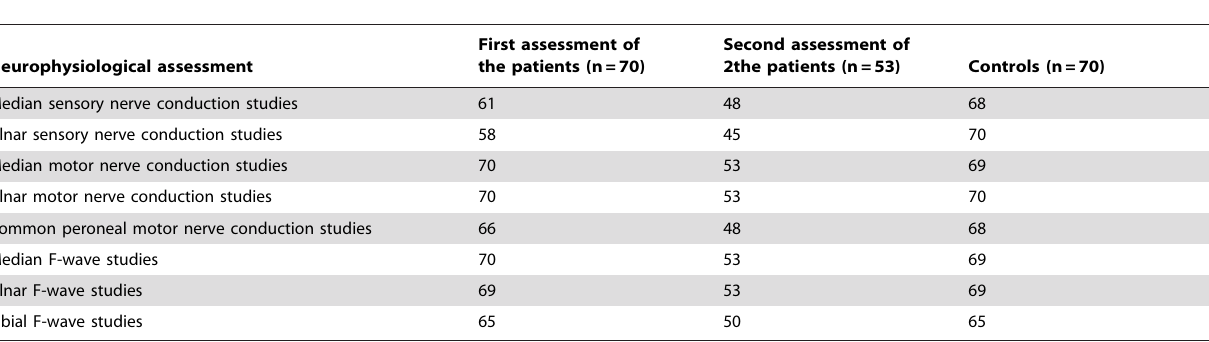
Table 3. The number of participants who underwent individual neurophysiological assessment.